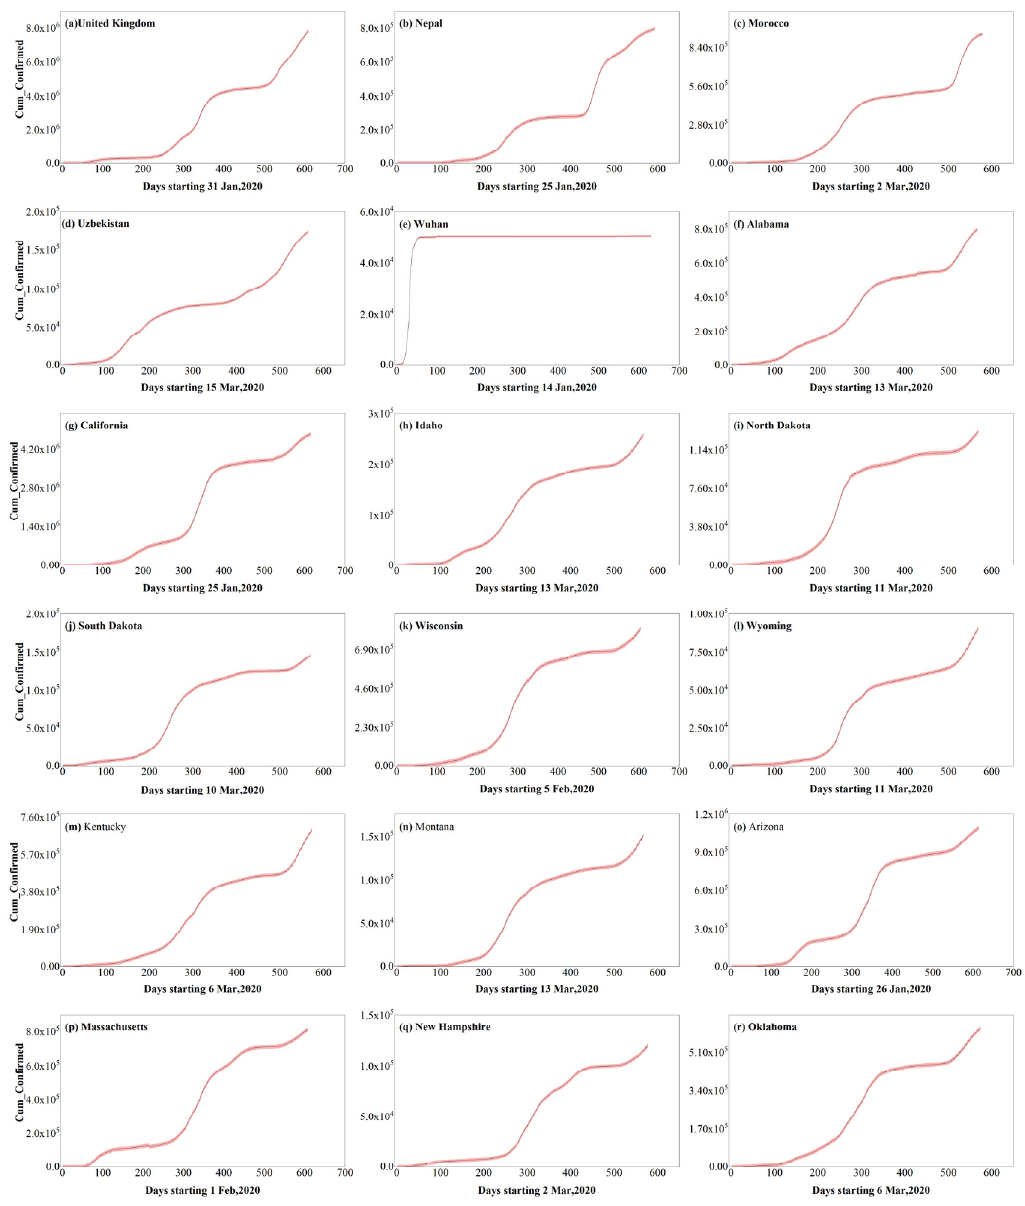
Figure 2. Cumulative confirmed cases in the countries and regions studied. Figure ( a – r ) represents the cumulative confirmed cases of COVID-19 in our study area and time respectively.